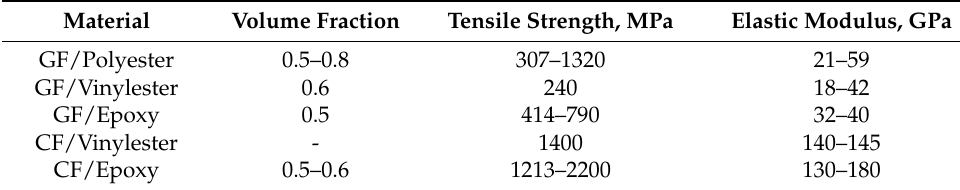
Table 4. Mechanical properties of thermoset pultruded